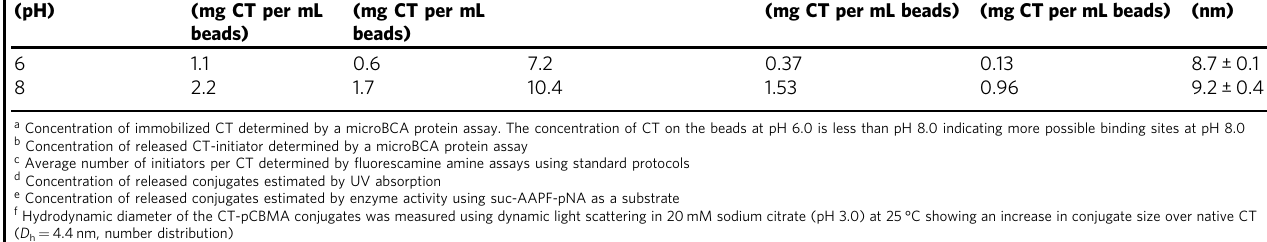
Table 6 Characterization of CT conjugates by PARIS fl ow reactor CT immobilization Protein on beads a